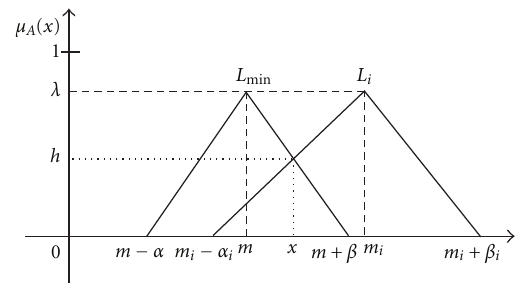
Figure 2: Level λ -triangular LR intersection